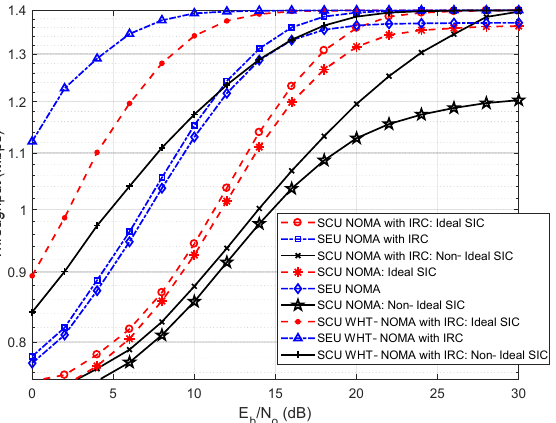
power allocation: SCU = 0.2 and EU = 0.8. allocation: SCU = 0.2 and EU = 0.8.